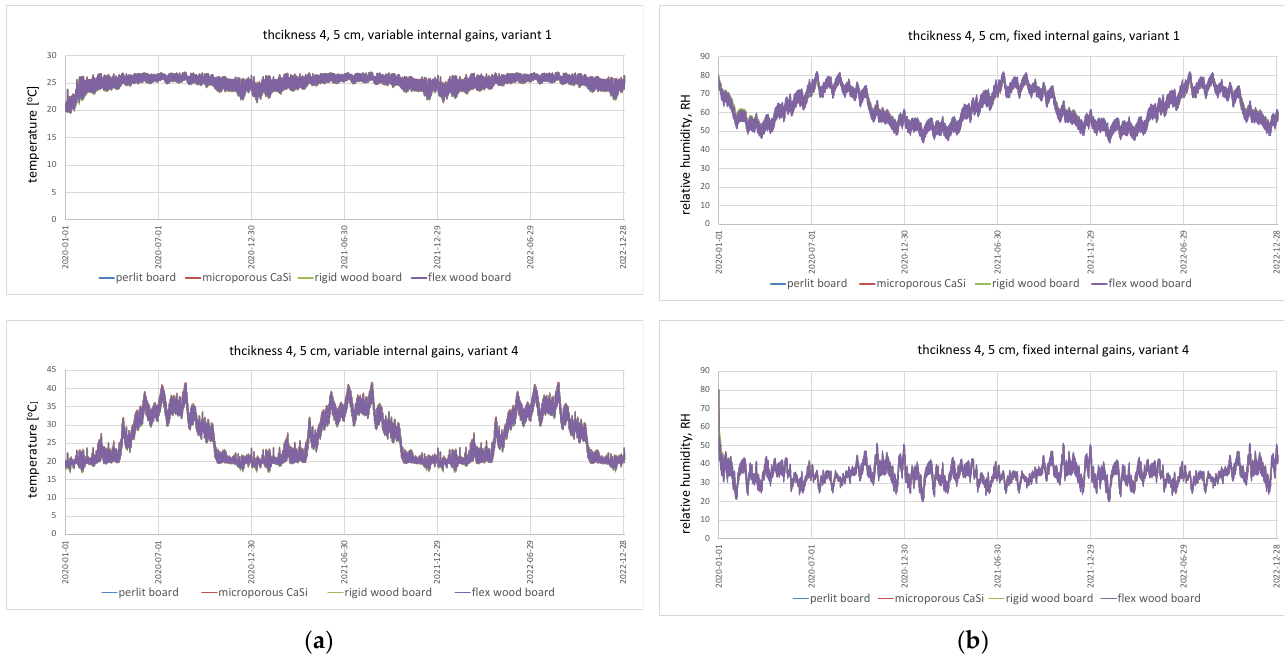
Figure 2. Annual seasonal fluctuations in temperature and relative humidity on the inner surface for 4 or 5 cm internal insulation thickness; ( a ) variable internal gains; ( b ) fixed internal gains. Table 5. Maximum and minimum values of temperature on the inner surface of the wall.